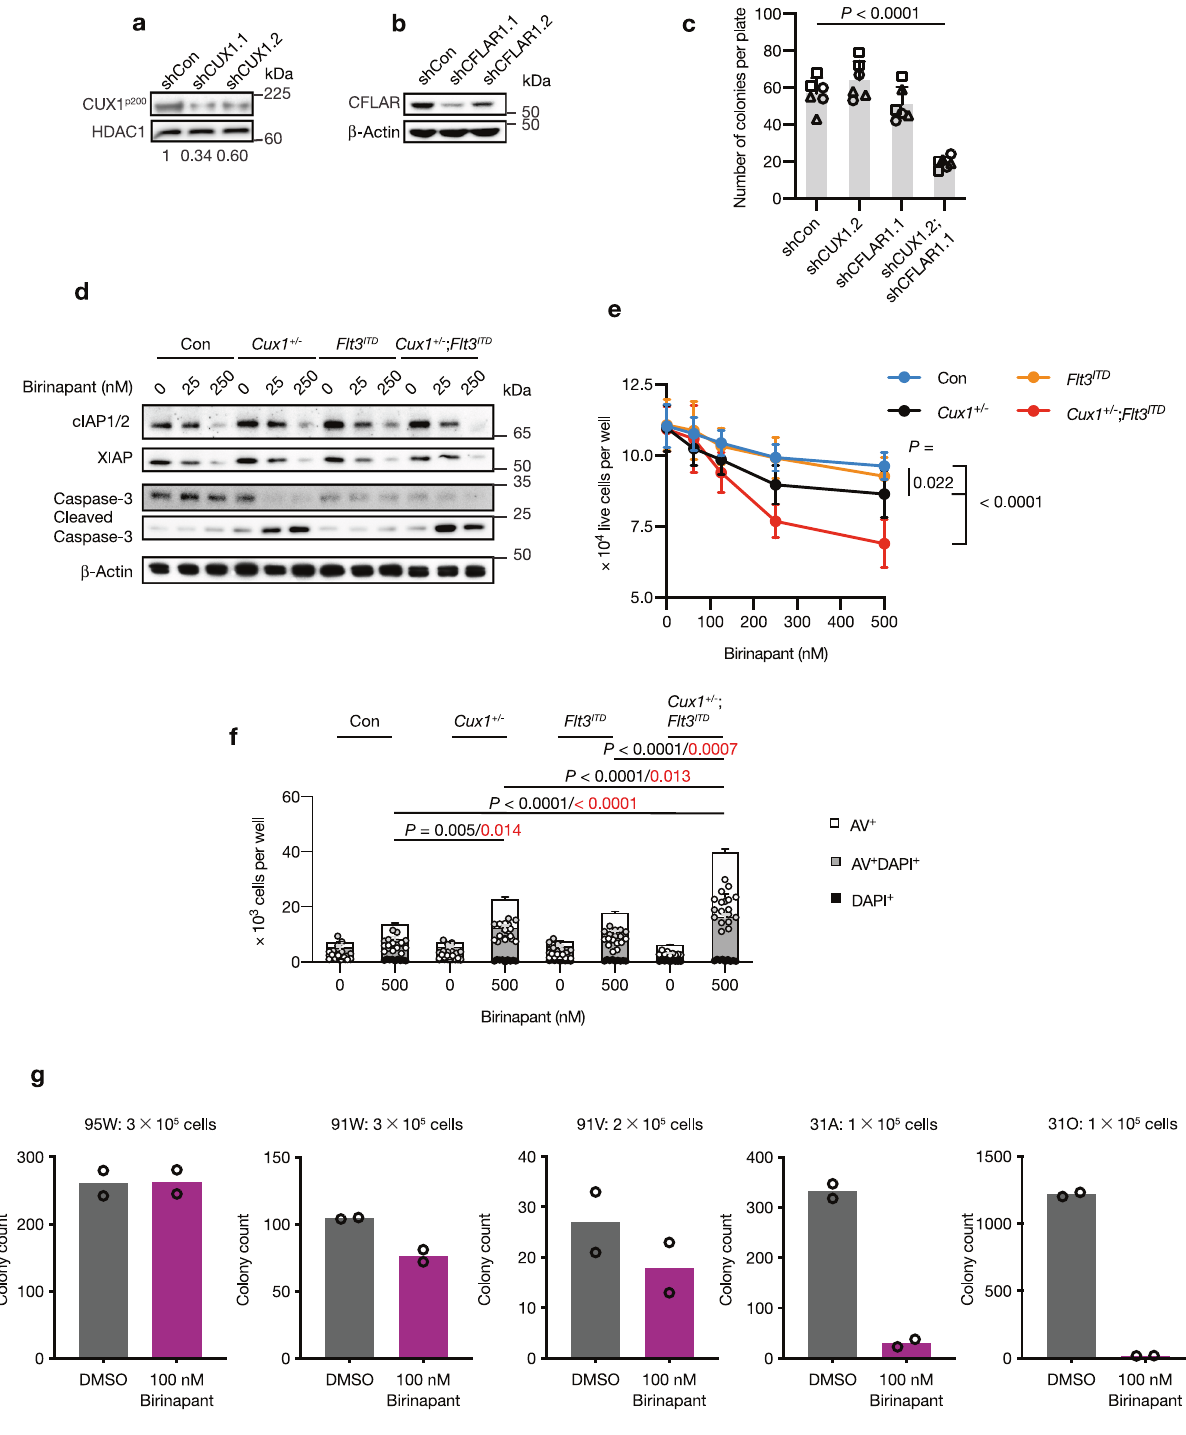
fi ltered viral supernatants using cell growth media supplemented with 8µg/ml polybrene (Sigma) for 12-16 h. G418 (1µg/ml, Gibco) was added 24 h later for MSCV-based infections, whereas puromycin (InvivoGen) was added to 1µg/ml to select for lentivirus-transduced cells were required. Mouse c-Kit + cells were isolated from hindlimb bone marrow using CD117 MicroBeads (Miltenyi) and resuspended in StemSpan SFEM media (STEMCELL Technologies) supplemented with glutamine, antibiotics and cytokines (mouse interleukin (IL)-3, 10 ng/ml; mouse IL-6, 10ng/ml; and mouse stem cell factor (SCF), 25 ng/ml; Peprotech). Cells were transduced by spinoculation at 800 × g for 2h at 32°C with viral particles previously bound to RetroNectin-coated (Takara)